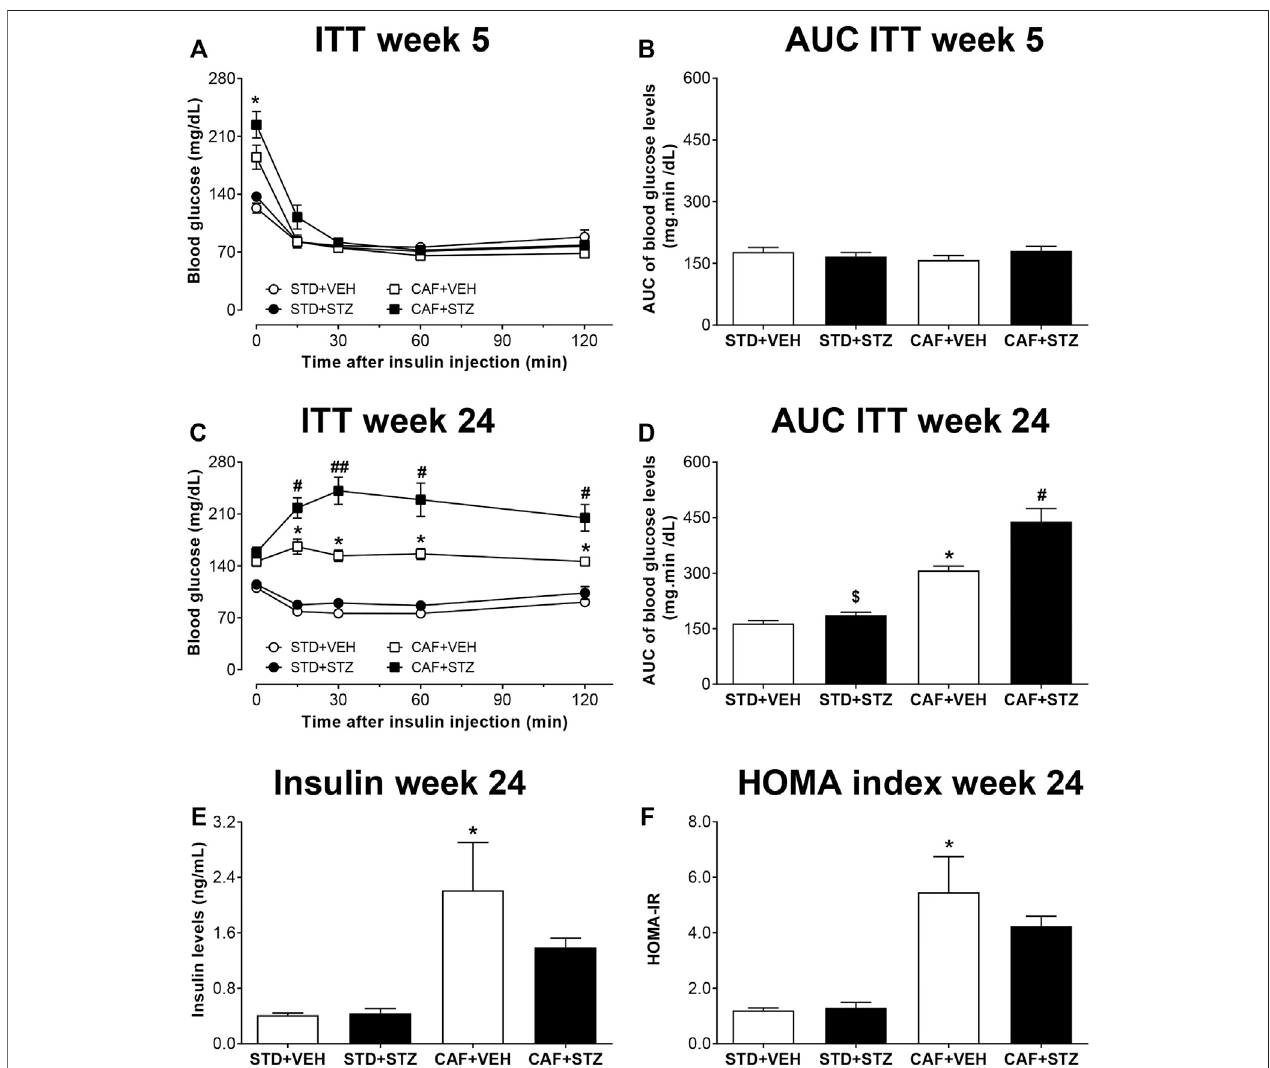
FIGURE 2 | Insulin tolerance test (ITT), insulin levels, and HOMA-index in C57BL/6J female mice with type-2 diabetes induced by CAF diet and low doses of STZ. Panels (A) and (C) show the blood glucose levels during an ITT at fi ve or 24 weeks after STZ-injections, respectively. Panels (B) and (D) are showing the area under the curve (AUC) calculated from the ITT. (E) Serum insulin levels and (F) HOMA2 index calculated 24 weeks post-STZ. Values are means ± SEM (n (cid:1) 8 – 10). In (A) * p < 0.05 for CAF [F (1,36) (cid:1) 7.01]. No statistical differences were observed in (B) . In (C) * p < 0.05 for CAF [F (1,36) (cid:1) 107.9]; # ( p < 0.05) ## ( p < 0.01) for the interaction CAF × STZ [F (1,36) (cid:1) 5.5]. In (D) * p < 0.05 for CAF [F (1,30) (cid:1) 76.81],$ ( p < 0.05) for STZ [F (1,30) (cid:1) 11.55],# ( p < 0.05) for the interaction CAF × STZ [F (1,30) (cid:1) 5.9]. InE, * p < 0.05 for CAF[F (1,25) (cid:1) 30.71].NostatisticaldifferenceswereobservedforSTZorCAF × STZinteraction( p (cid:1) 0.09).In (F) p < 0.05forCAF[F (1,25) (cid:1) 52.82].Nostatisticaldifferences were observed for STZ or CAF × STZ interaction. Data in (A) and (C) were analyzed by Repeated-Measures Three-Way ANOVA followed by Bonferroni multiple comparison. Data in (B – F) were analyzed by Two-Way ANOVA. STD: Standard diet; CAF: Cafeteria diet; VEH: Vehicle; STZ: Streptozotocin.